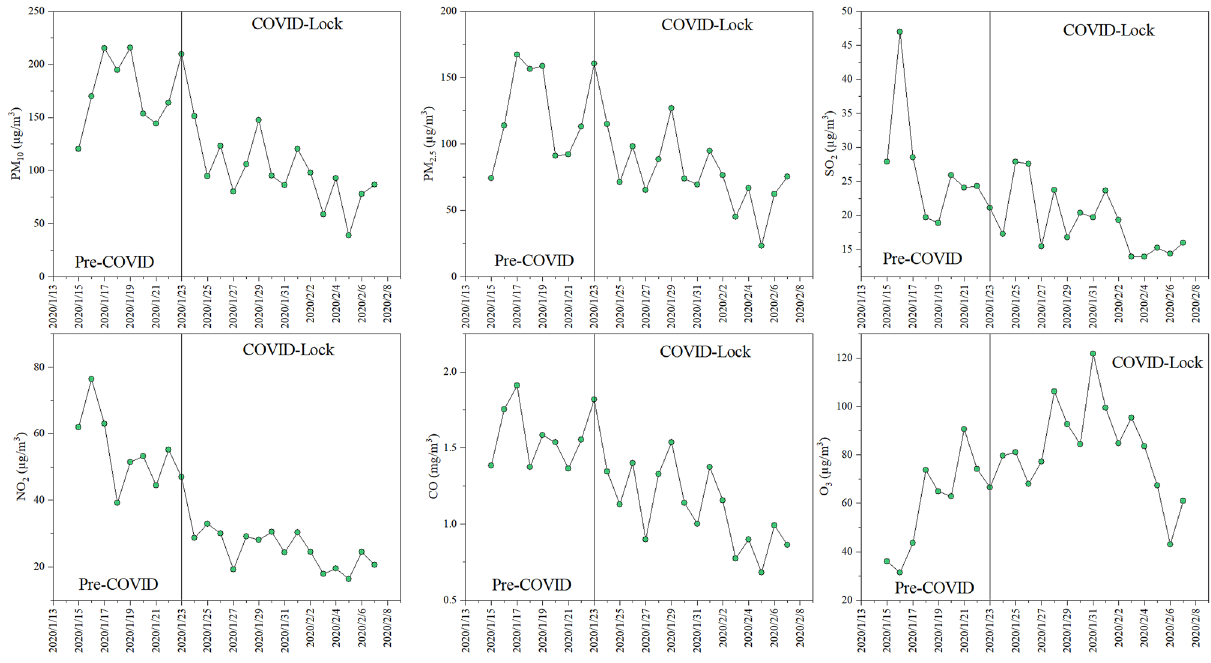
Figure 2. Temporal variations in the mass concentrations of air pollutants (PM 10 , PM 2.5 , NO 2 , SO 2 , CO and O 3 ) at the urban site in Ji’nan during the observation